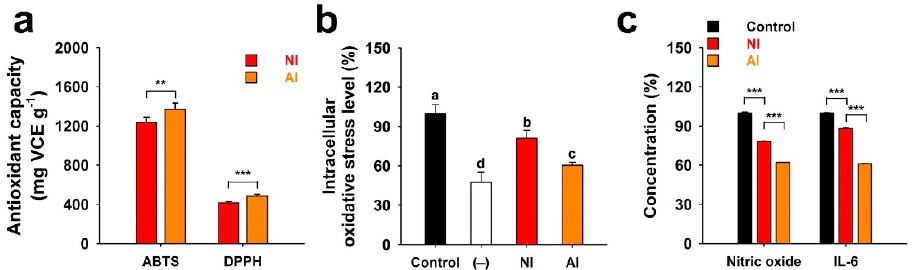
Figure 5. Antioxidant and anti-inflammatory activities of the non-hydrolyzed isolate (NI) and acidolyzed isolate (AI) of Ginkgo biloba leaf. ( a ) Antioxidant capacity expressed as vitamin C equivalents (VCE) · g − 1 of NI and AI determined using ABTS and DPPH radicals. ( b ) H 2 O 2 (100 µ M)-induced oxidative stress levels of the PC-12 cells treated with 10 µ g · mL − 1 of NI and AI [Control, no sample-treated group; ( − ), no H 2 O 2 - or sample-treated group]. Data with di ff erent letters represent significant di ff erences according to the Tukey’s test ( n ≥ 3; mean ± SD; P < 0.05). ( c ) Lipopolysaccharide (100 ng · mL − 1 )-induced generations of nitric oxide and interleukin 6 (IL-6) from the RAW 264.7 macrophages treated with 20 µ g · mL − 1 of NI and AI. Student’s t -test: **, P < 0.01; ***, P < 0.001.